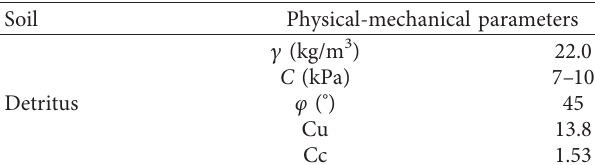
Figure 5: Layout of measuring elements.